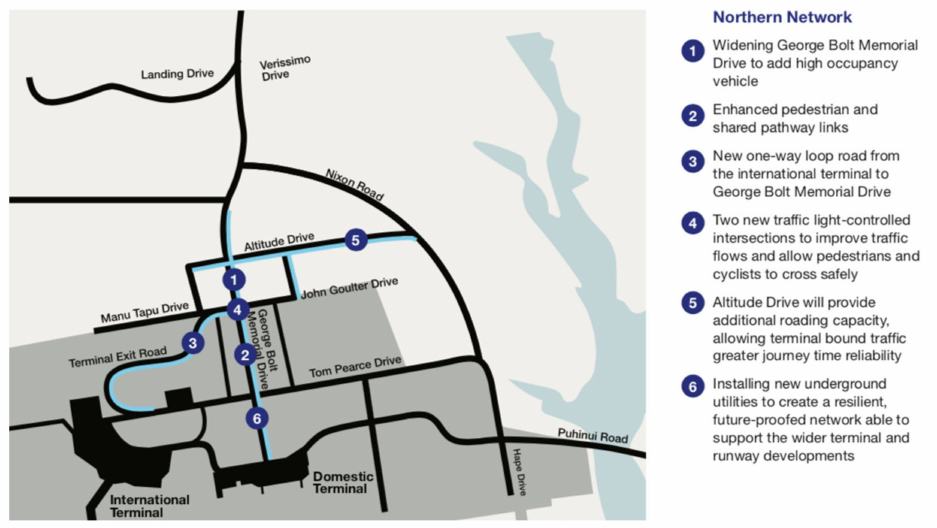
Figure 4. Airport Network Transportation Upgrade project